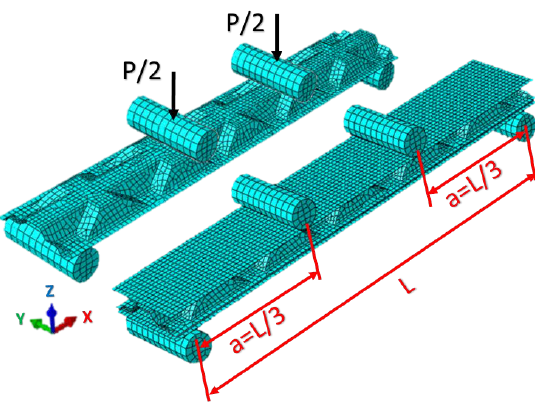
Figure 4. Finite element (FE) model of 3-D core and sandwich panel in the longitudinal direction. Table 1. Dimensions of flexural specimens used in the bending test.